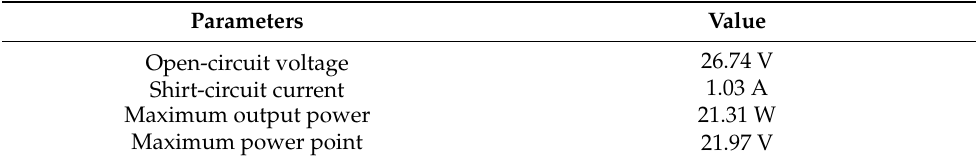
Table 3. Six test patterns.